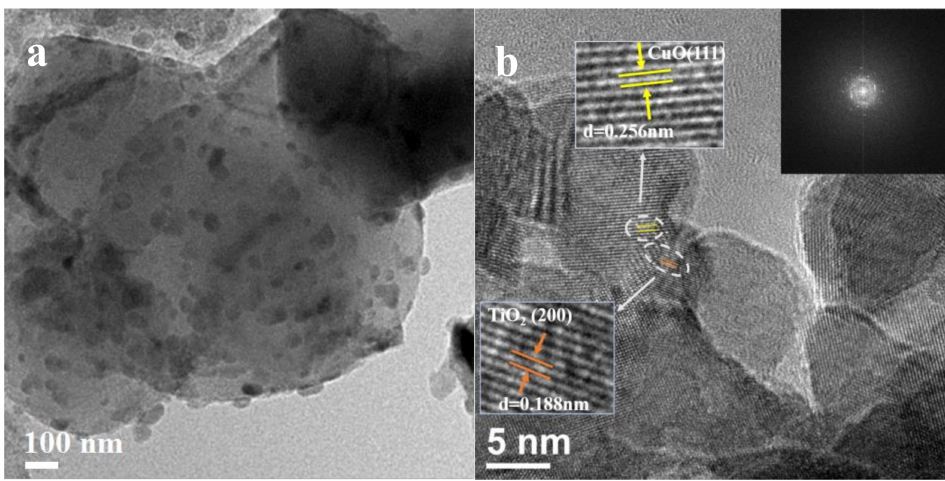
Figure 3. TEM images of CuO/TiO 2 -5 catalyst in ( a ) low magnification and ( b ) high magnification (the insets are FFT pattern and the detailed images of white dashed